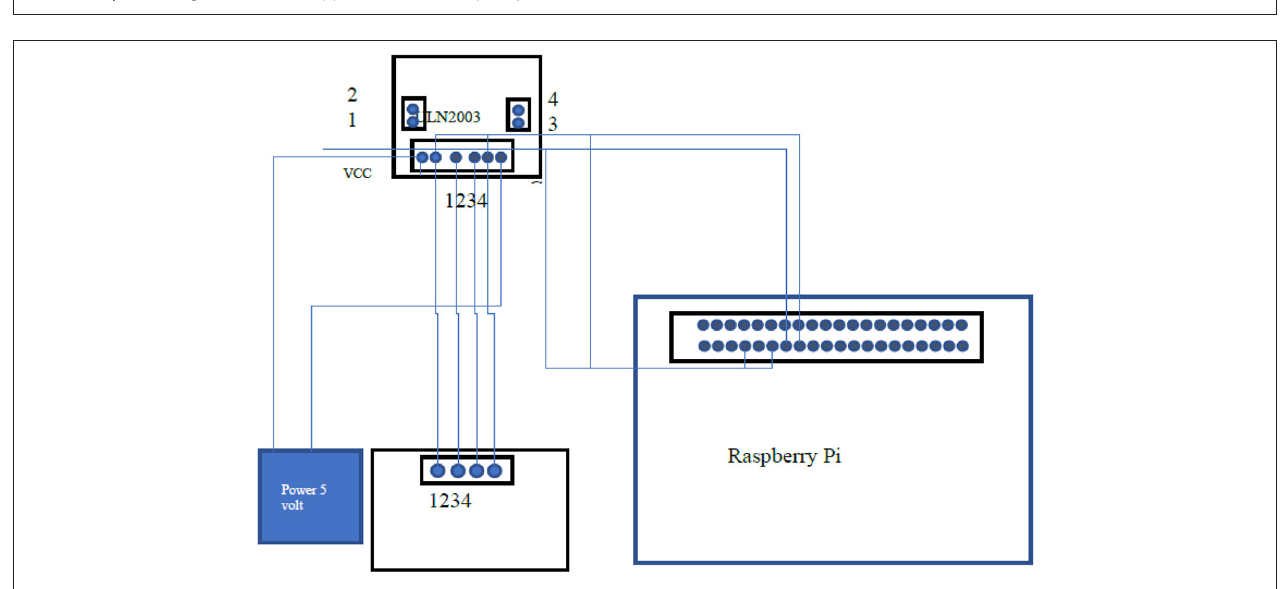
FIGURE 8 | Interfacing of RJ2003 stepper motor with Raspberry